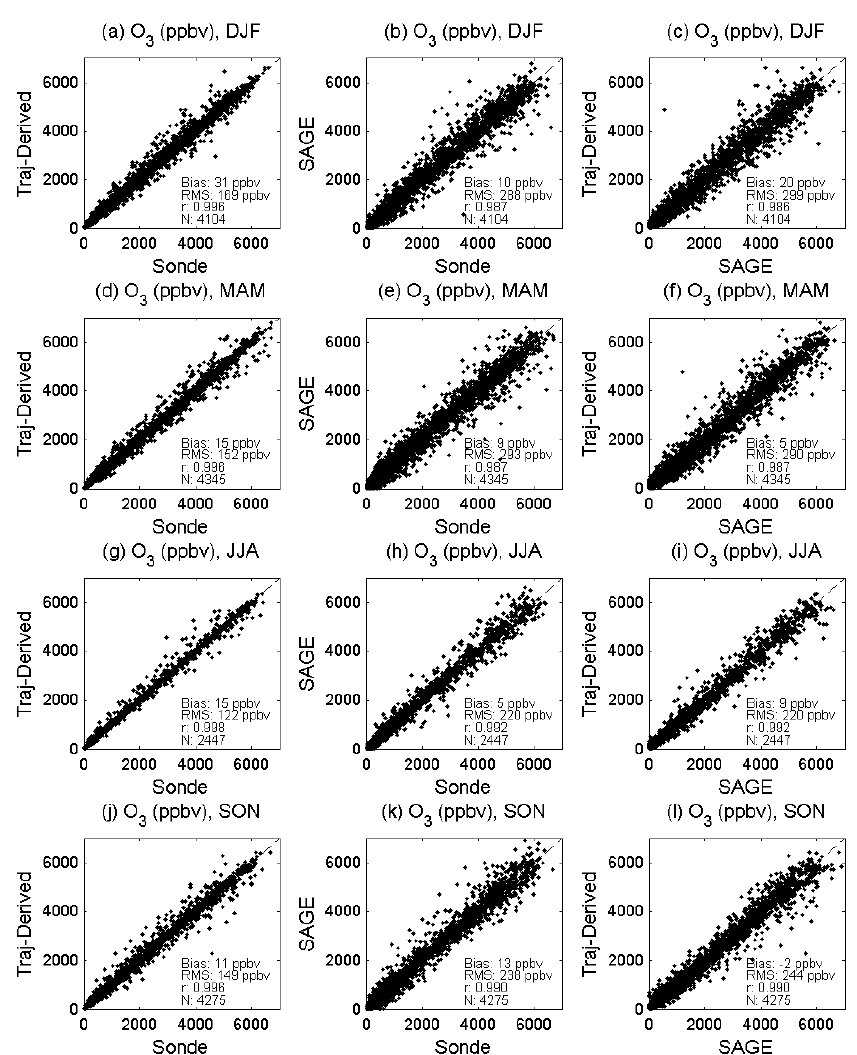
Fig. 5. Correlation ( r ) of ozone mixing ratio between trajectory-derived, SAGE, and ozonesonde data for the 1990s and 2000s for NH winter (1st row), spring (2nd row), summer (3rd row), and winter (4th row). The dashed line shows the 1:1 axis. N denotes the number of data points and RMS the root mean square error. All correlations are significant at a level better than 1%.